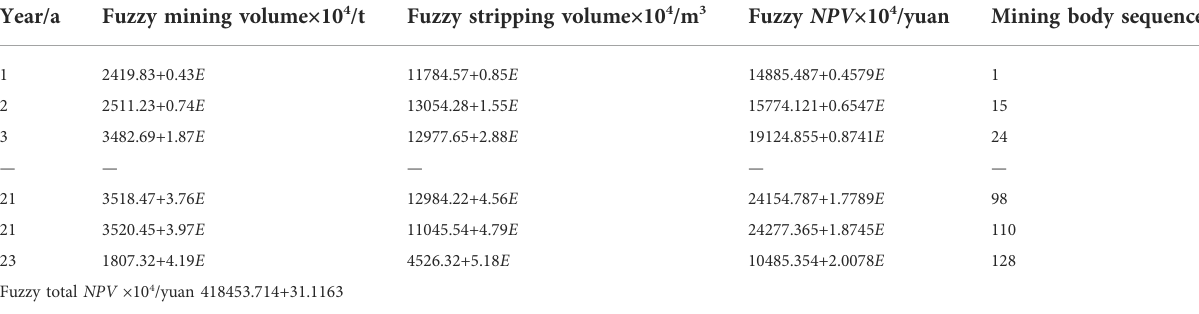
TABLE 7 The optimization results of